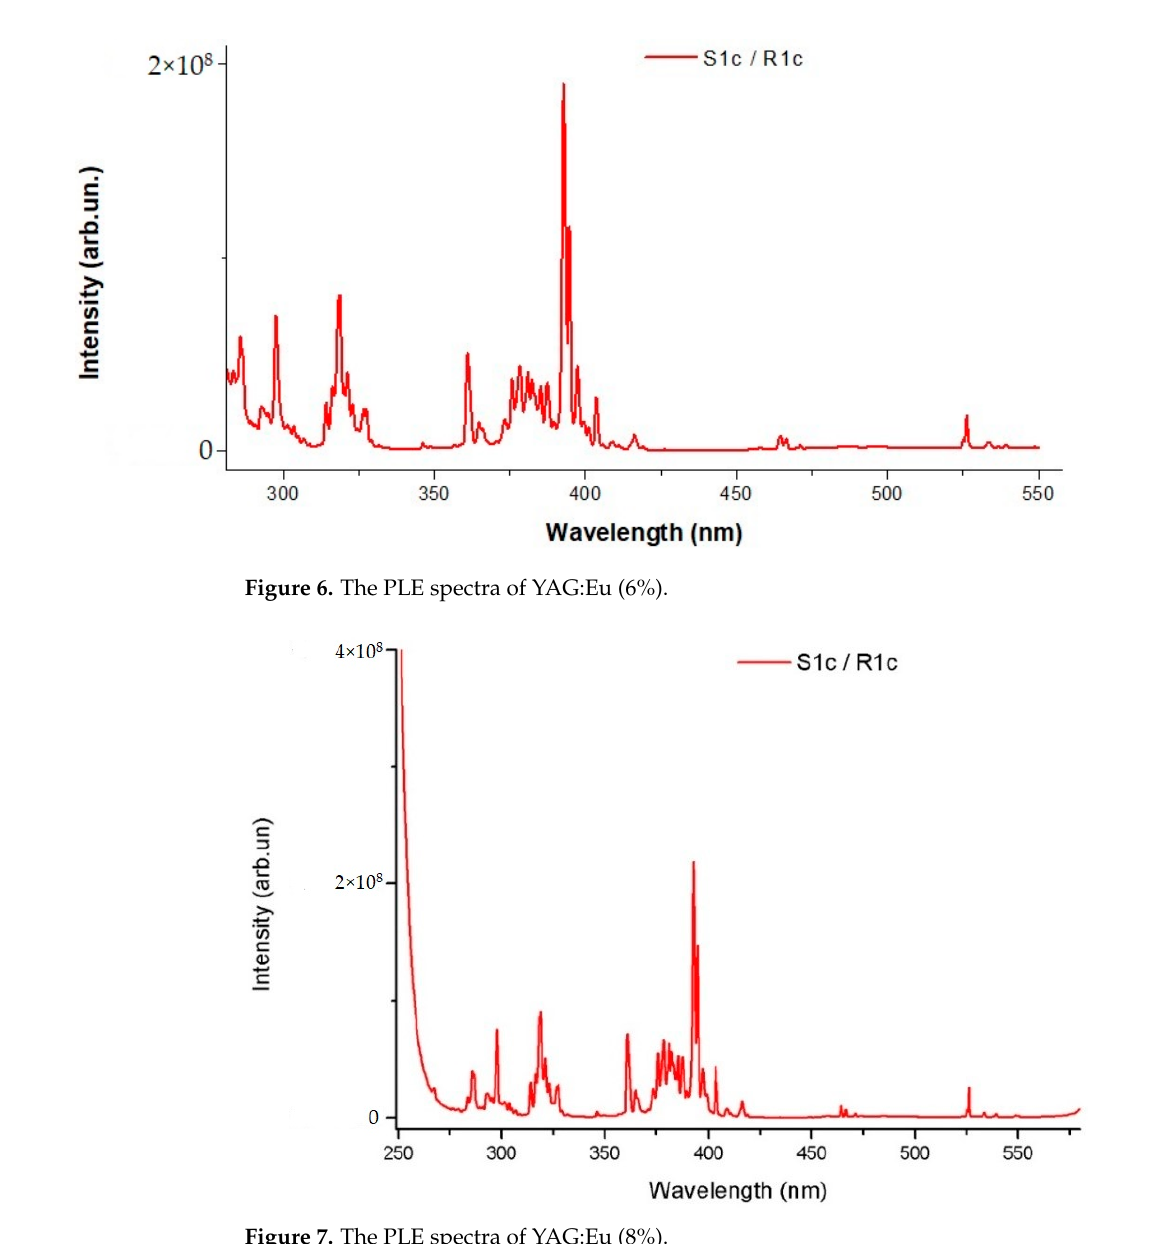
Figure 7. The PLE spectra of YAG:Eu (8%).